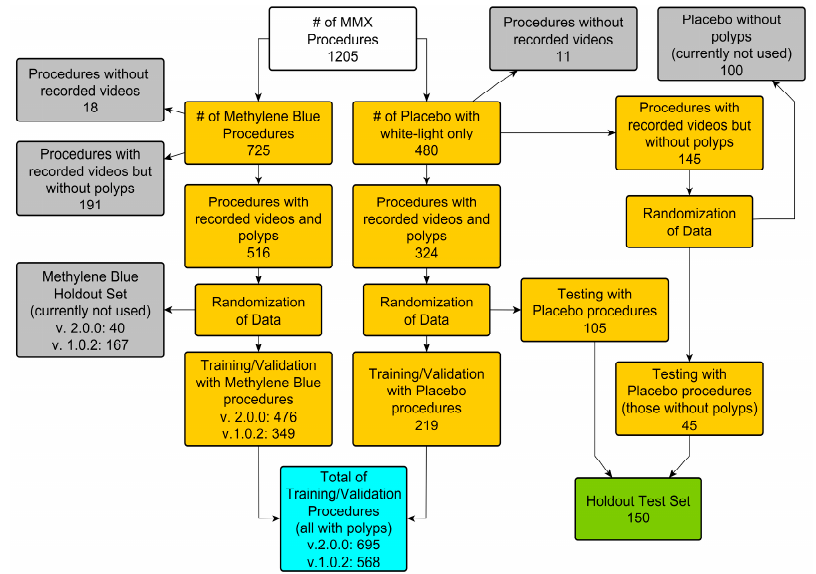
Figure 2. Dataset subdivision for GI Genius CADe v1 and v2. Both versions of CADe have been trained using the data from the international multicenter MB-MMX study (ClinicalTrials.gov NCT01694966 [39]). Both procedures from the methylene blue arm and the placebo arm were recorded using a lossless video compression format. In addition, the holdout test set patients were used for the first standalone CADe performance assessment [14].